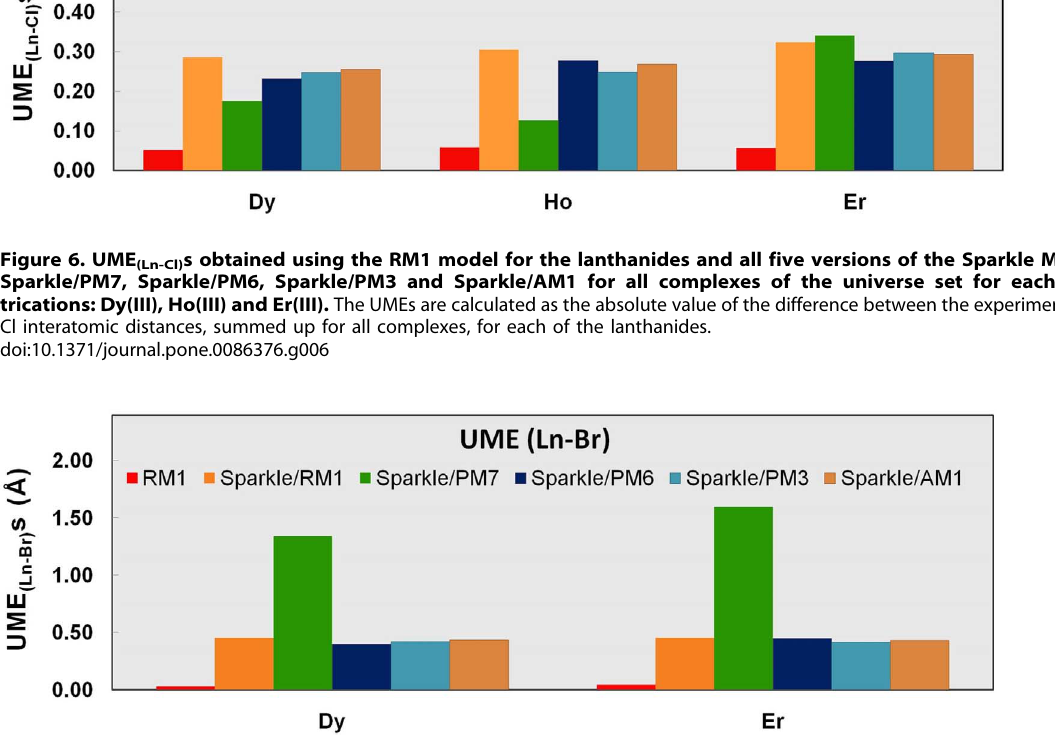
Figure 7. UME (Ln-Br) s obtained using the RM1 model for the lanthanides and all five versions of the Sparkle Model: Sparkle/RM1, Sparkle/PM7, Sparkle/PM6, Sparkle/PM3 and Sparkle/AM1 for all complexes of the universe set for each of the lanthanide trications: Dy(III), Ho(III) and Er(III). The UMEs are calculated as the absolute value of the difference between the experimental and calculated Ln- Br interatomic distances, summed up for all complexes, for each of the lanthanides. The RM1 model for lanthanides UME (Ln-Br) bars are very small.